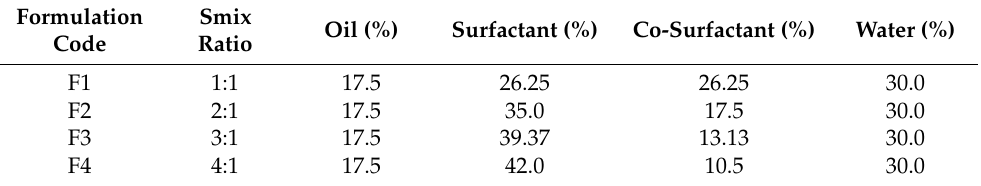
Table 1. Composition of selected ETO-NE passed thermodynamic stability tests.